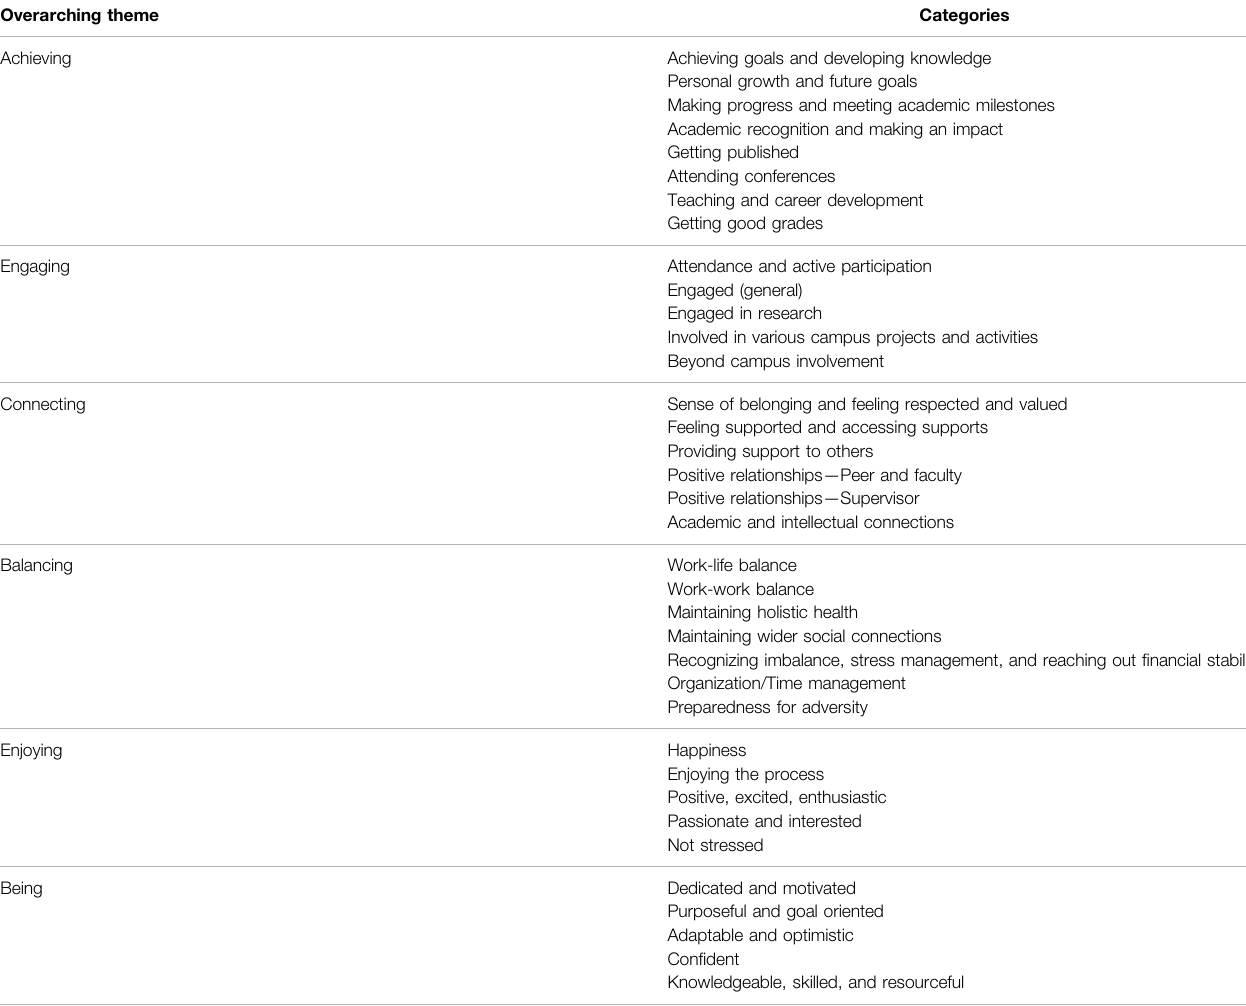
TABLE 1 | Overview of the overarching themes and categories emerging from qualitative analysis. Overarching